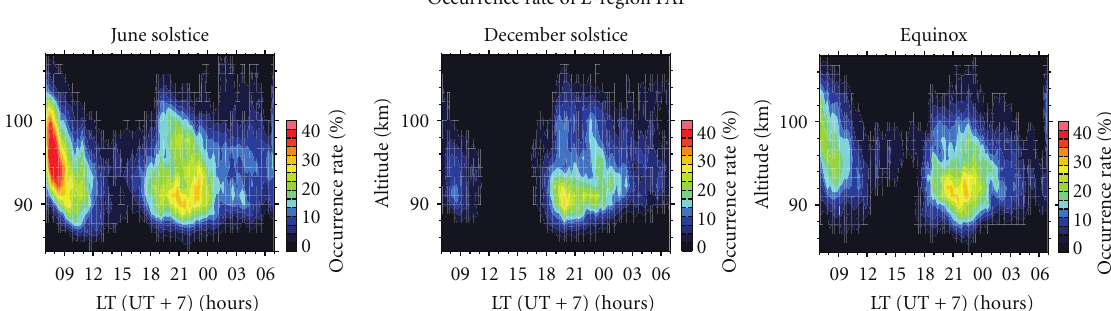
Figure 3: Local time and altitude variations of FAI occurrence rate at Kototabang, Indonesia, for (a) June solstice, (b) December solstice, and (c) equinox seasons in 2007.